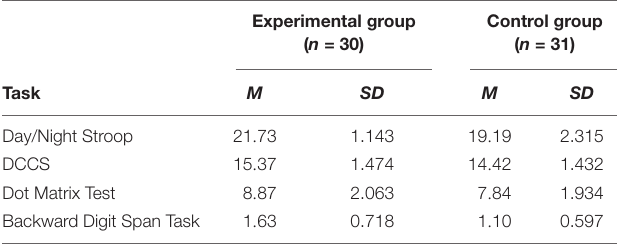
TABLE 8 | After-effect description statistics at T3.